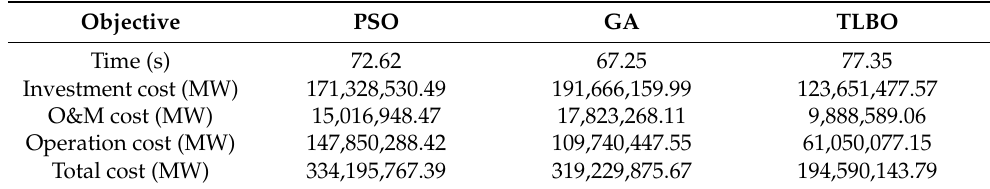
Table 4. Result of